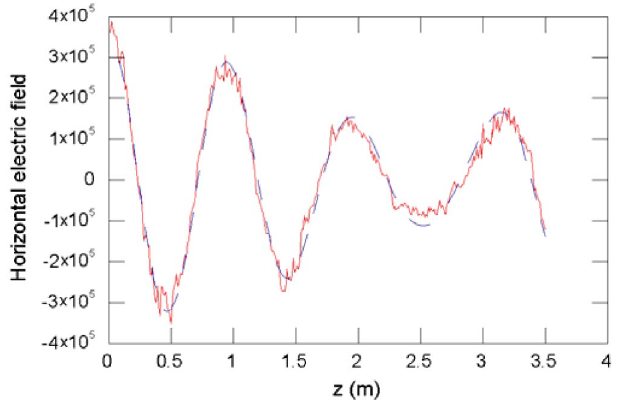
FIG. 14. (Color) Comparison of the electron centroid grid and analytic electric fields, using method 2, without fractional ion- ization. The solid red line shows the electric field calculated on the simulation grid and the dashed blue line shows the electric field calculated by the analytic